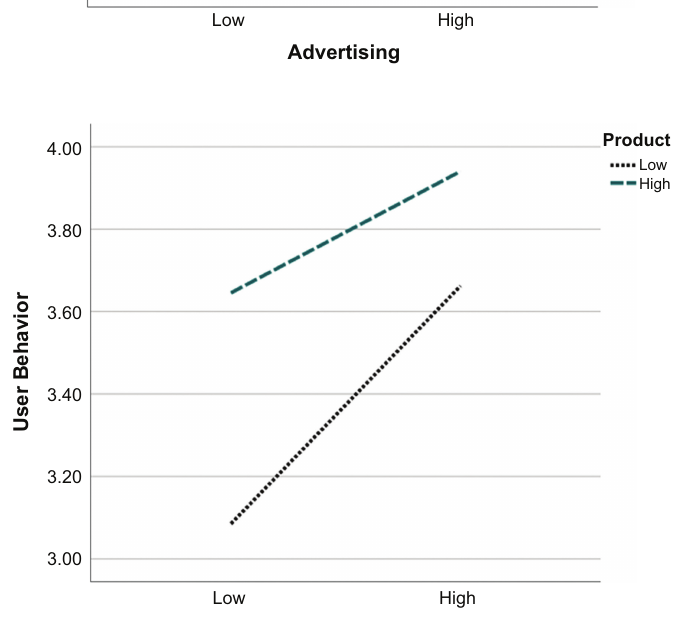
Figure 4. Product as a